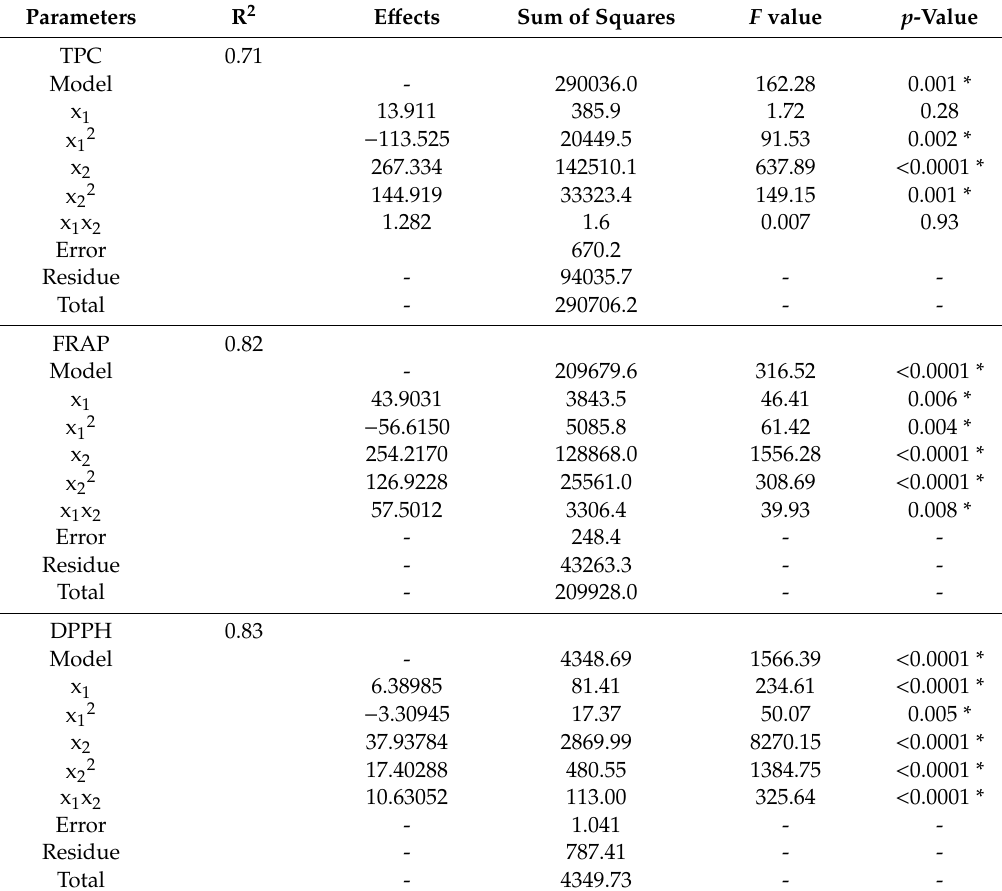
Table 3. Analysis of variance (ANOVA) for total phenolic content (TPC) and antioxidant capacity by the FRAP and DPPH